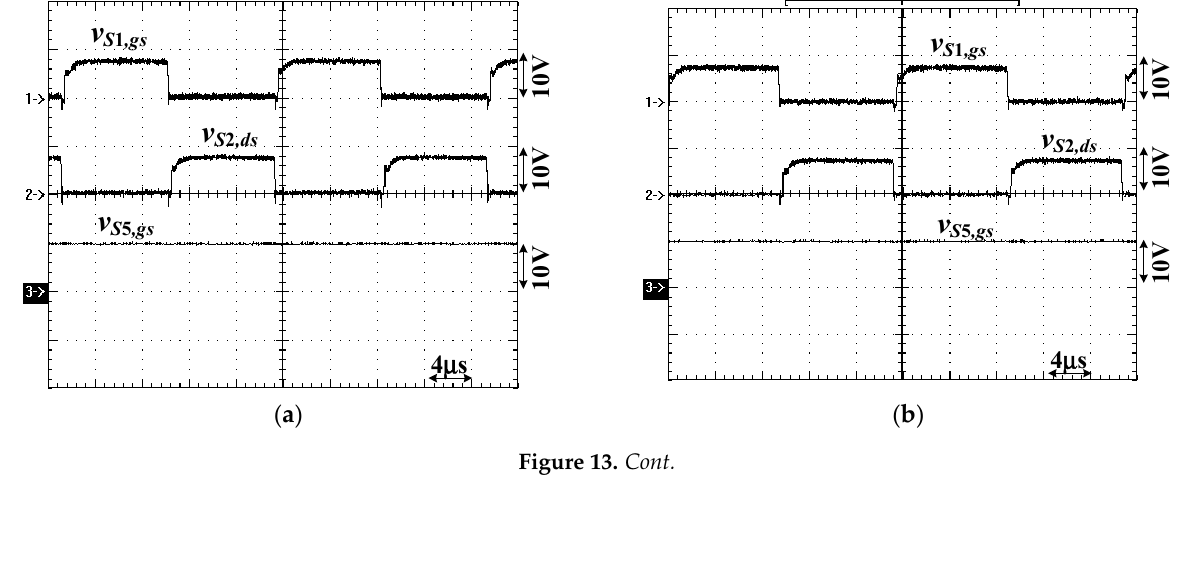
Figure 12. Measured waveforms of the proposed converter operated at forward power flow and V in = 202 V: ( a ) S 1 – S 4 signals at 20% load power, ( b ) S 1 – S 4 signals at 100% load power, ( c ) v ab , i Lr,p and v Cr,p at full rated power, ( d ) i Lr,s , v Cr,s , i Q 1 + i Q 3 and I o at full rated power.